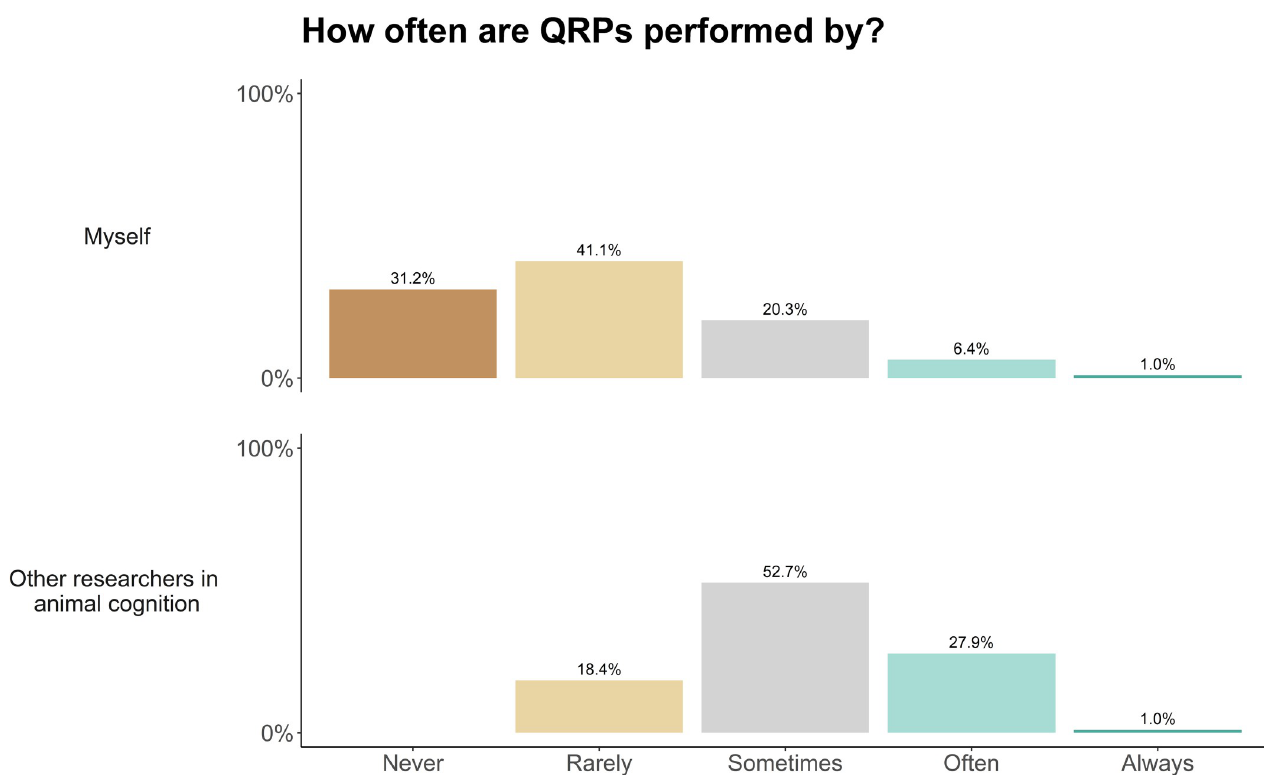
Fig 12. Animal cognition researchers’ self-reported use of questionable research practices, and their estimated use of questionable research practices (QRPs) by other researchers in the